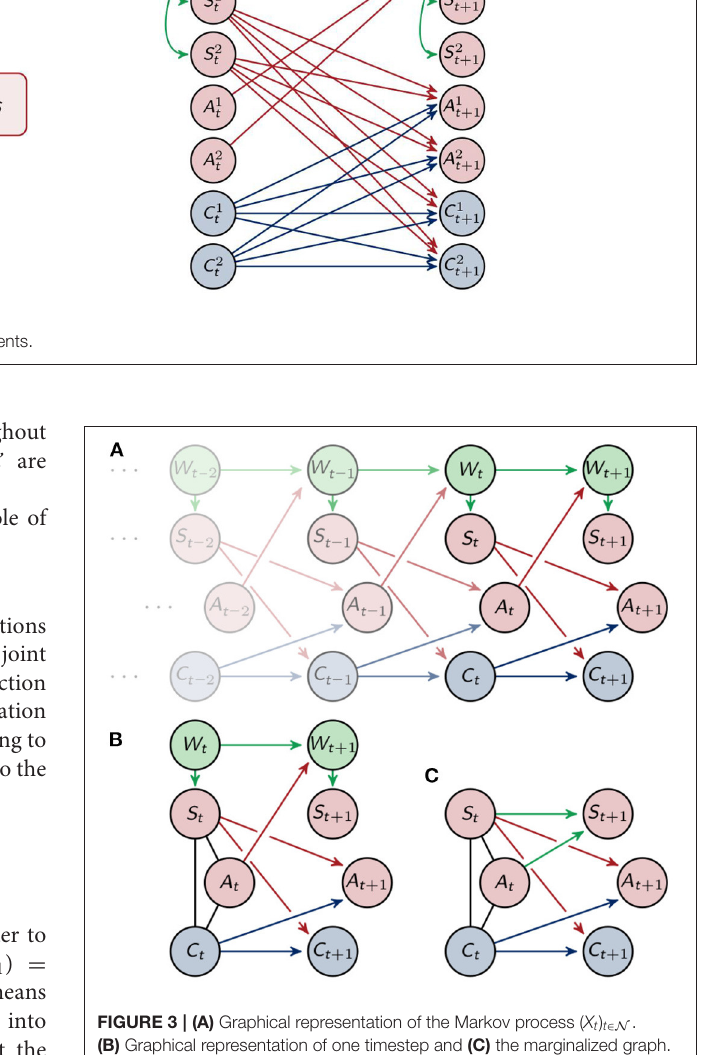
FIGURE 3 | (A) Graphical representation of the Markov process ( X t ) t ∈ N . (B) Graphical representation of one timestep and (C) the marginalized